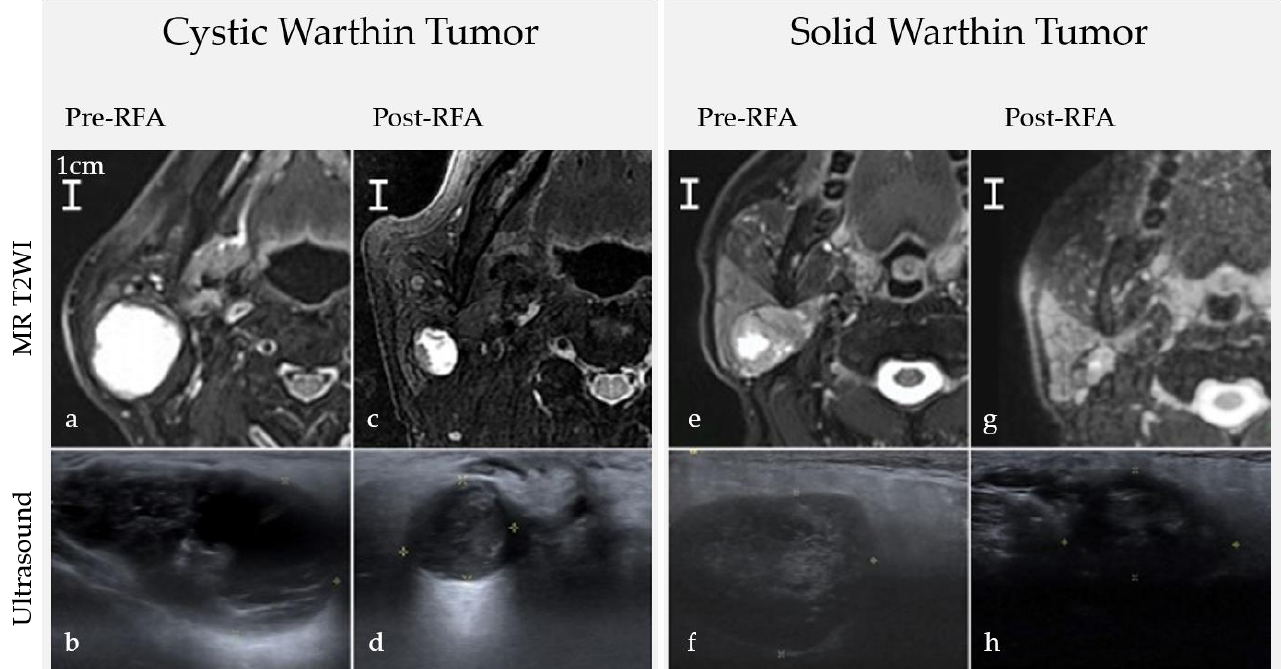
Figure 3. Images before and after RFA comparing consistencies and locations. ( a , b ) A huge right cystic Warthin tumor (35.47 mL) ( c ) Post-RFA 8 months VRR = 93.3%. ( d ) Post-RFA 1 months VRR = 68.8%. ( e , f ) A right solid Warthin tumor (18.13 mL) ( g ) Post-RFA 12 months VRR = 79.2%. ( h ) Post-RFA 1-month VRR = 51.5%. These two tumors were initially located in both superficial and deep lobes. After RFA, residual tumors were located in superficial lobes only. MR T2WI = Magnetic resonance T2-weighted image.